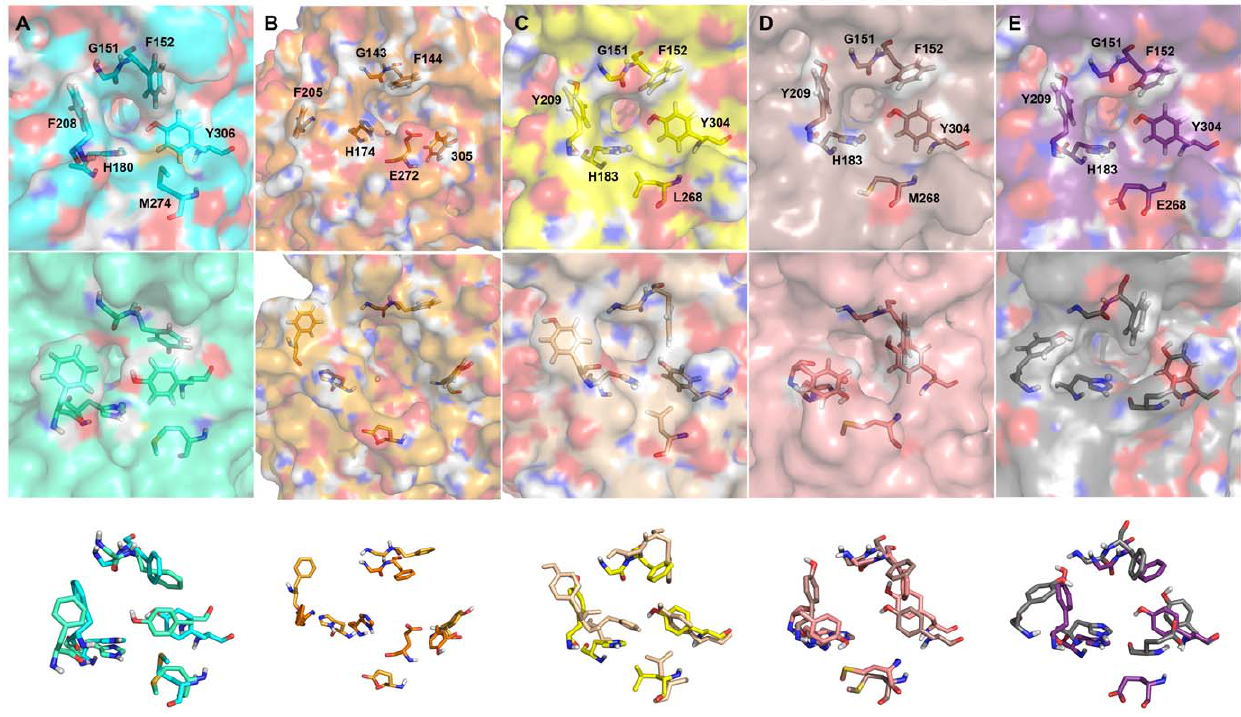
Figure 6. Surface views showing tunnels and tunnel forming residues of initial and average structures. (A) Initial and average structures of HDAC8 are shown in cyan and pale green colors. (B) Initial and average structures of HDAC10 are shown in dark and light orange colors. (C) Initial and average structures of HDAC11 are shown in yellow and wheat colors. (D) Initial and average structures of HDAC11 L268M are shown in dark salmon and salmon colors. (E) Initial and average structures of HDAC11 L268E are shown in violet and grey colors, respectively.